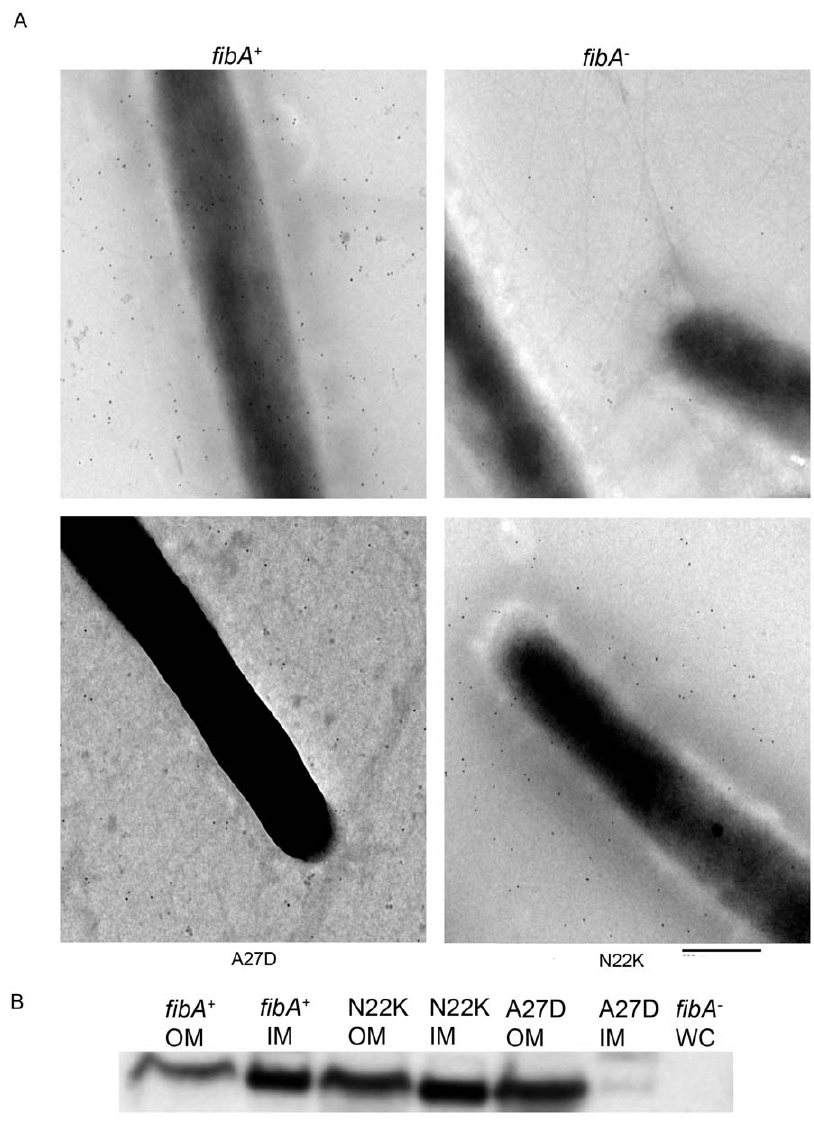
Figure 4. Identification of M.xanthus lipoprotein sorting signals. (A) Immuno transmission electron microscopy of developing cells using monoclonal antibody Mab2105. M. xanthus cells were allowed to form a biofilm on a formvar-carbon-coated nickel grid for 3 h. The cells were probed with Mab2105, which reacts primarily with FibA followed by anti-mouse antibodies conjugated with 10 nm colloidal gold particles. Bar is 500 nm. (B) Western blot analysis of membrane fractions purified from 7–8 h developing cells.